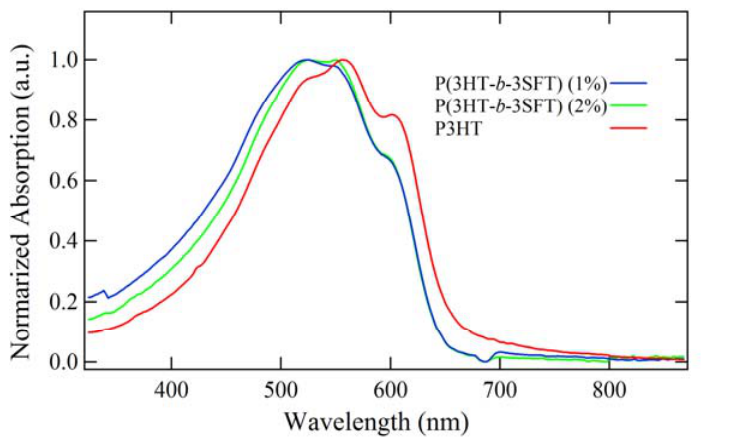
Figure 3. UV-Vis spectra of thin films of P(3HT- b -3SFT)s synthesized by